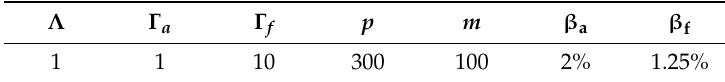
Table 1. DMC parameters of 600 MW drum-type thermal power plant.